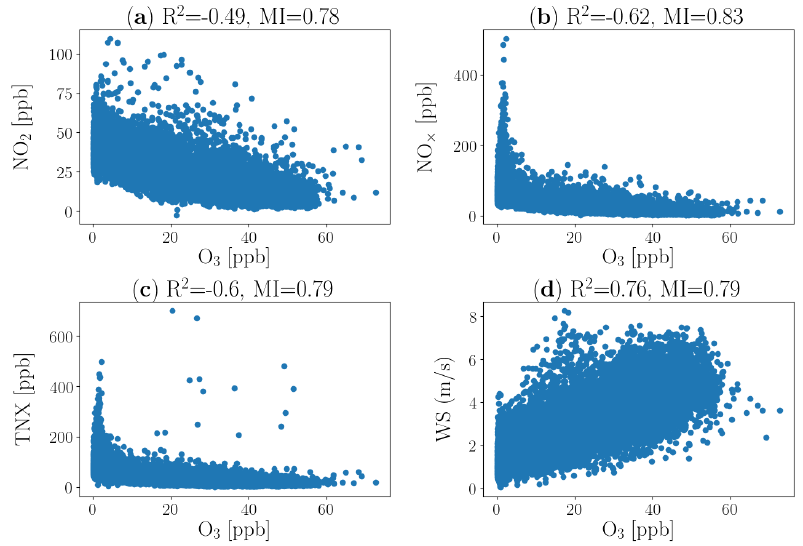
Figure 6. The scatter plot between O 3 concentration and several selected variables, including NOx, wind speed, m , p -Xylene (TNX) and NO 2 . R 2 is Pearson correlation coefficient (PCC), whereas MI is mutual information score. The concentration unit of trace gases and TNX is in part per billion (ppb) whereas the unit of wind speed is in